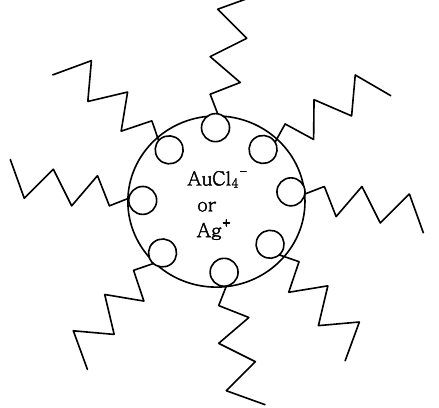
Pictorial presentation of inverse micelle formation. Fig.